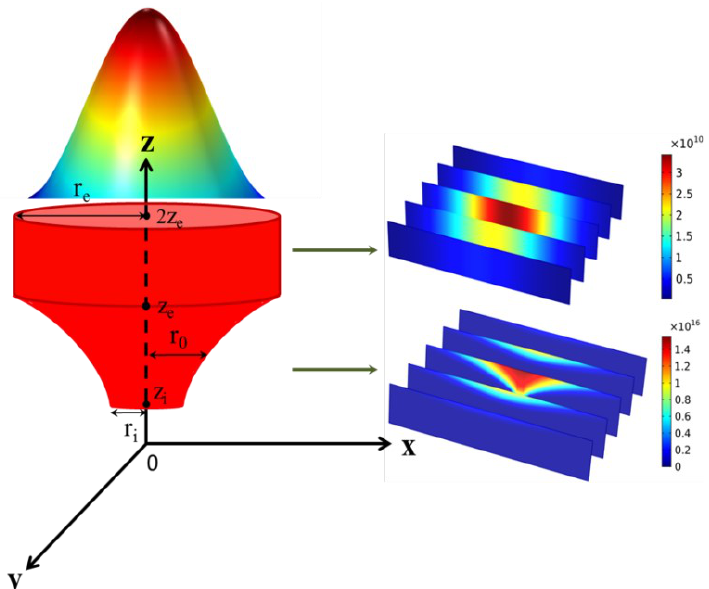
Figure 1. Schematic diagram of the heat source model and the interaction positions in the combined model. The upper part (parabolic rotating distribution volume heat source model) reveals the laser– powder interaction on the powder bed surface; the lower part (a cylindrical distribution Gaussian heat source model) reveals the laser–powder interaction inside the powder bed.